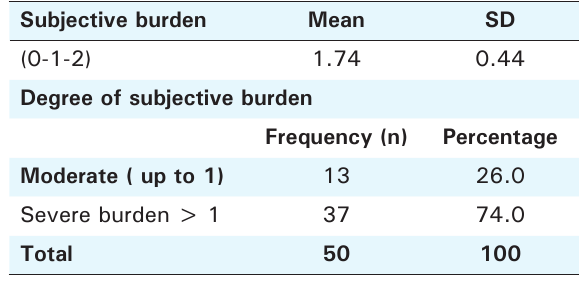
Table 6. Family burden (Objective) perceived by spouses of Opioid Dependent Subjects in different problem areas